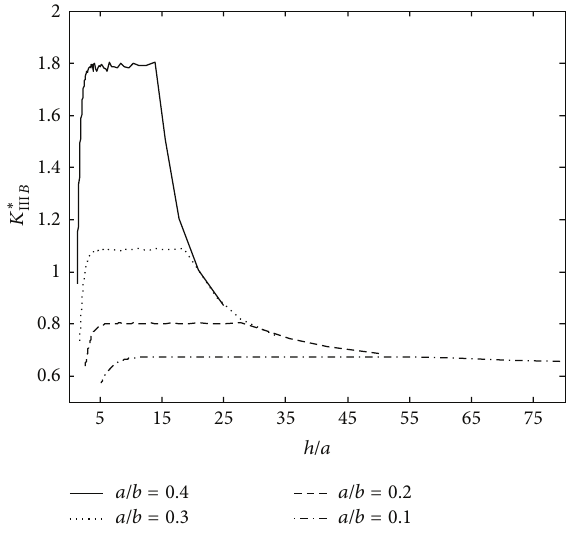
Figure 5: Various SIF of crack-tip 𝐶 with 𝑎/ℎ . Figure 6: Various SIF of crack-tip 𝐵 with ℎ/𝑎 for 𝑎/𝑏 = 0.1, 0.2, 0.3, and